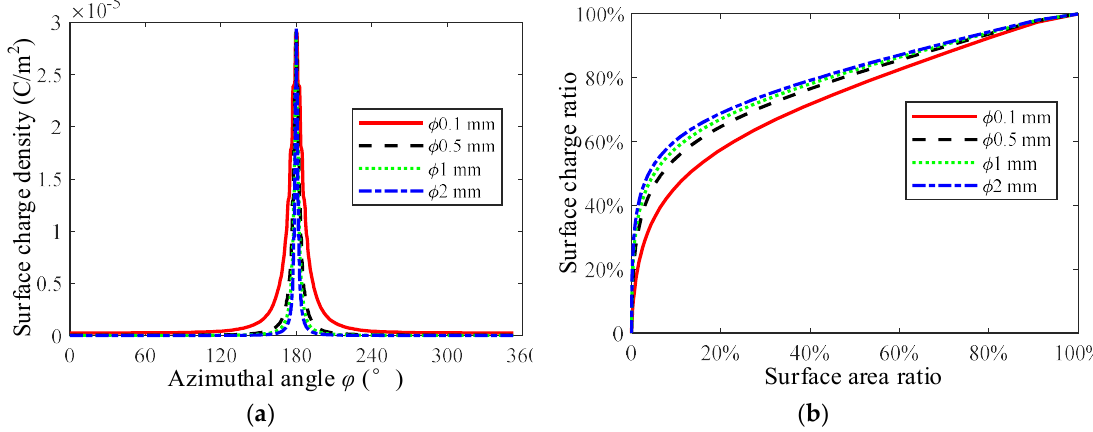
Figure 8. ( a ) Surface charge density on the equator of the probing ball; ( b ) surface charge ratio as a function of the surface area ratio.